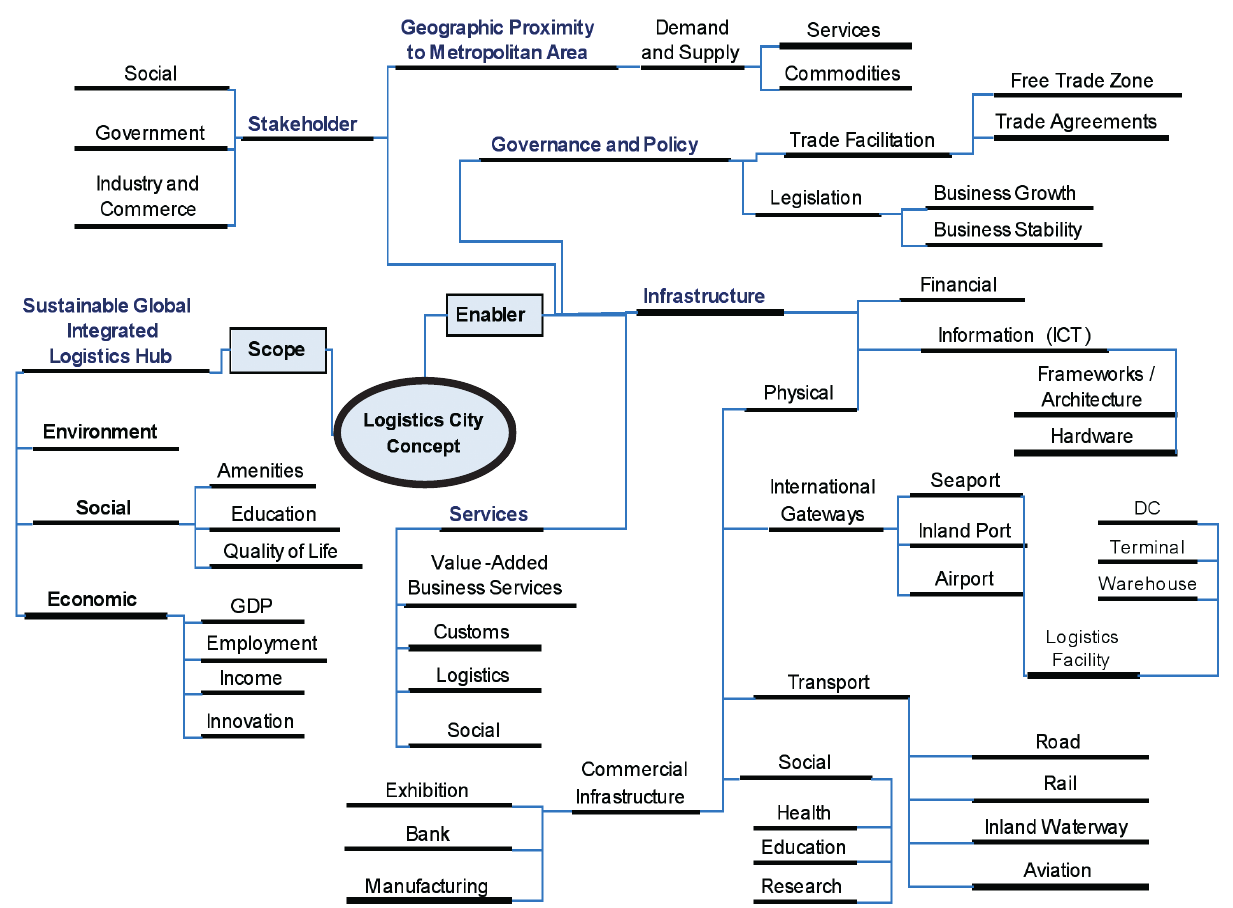
Figure 2: Conceptual map of the logistics